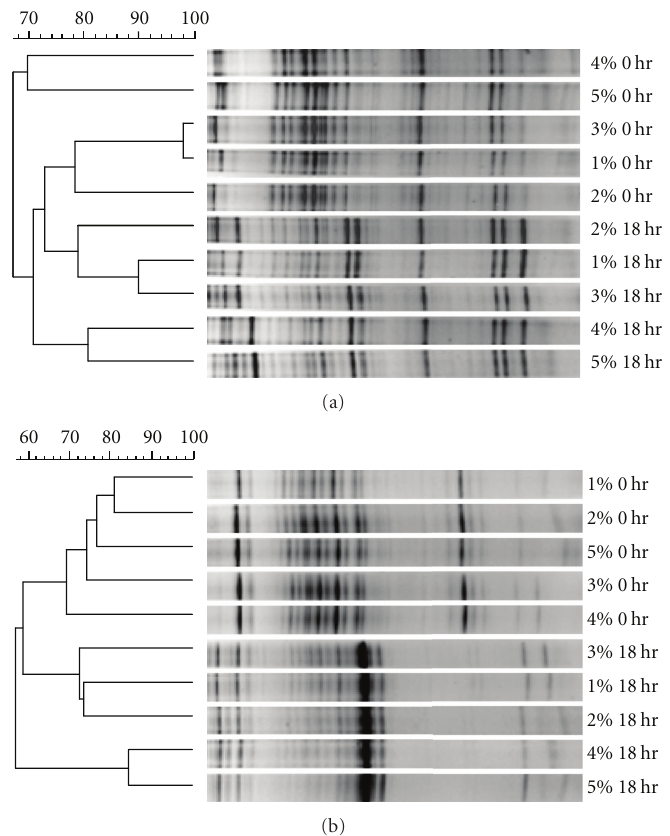
Figure 2: The comparison of DGGE profiles from di ff erent inoculum amounts. The clustering analysis based on Dice coe ffi cient and DGGE profile obtained at zero time and after 18 hours. The percentage indicated the inoculum amount of fecal materials. (a) The profiles obtained from individual B. (b) The cluster analysis were conducted with profiles of individual C. Table 3: Quantification of total bacteria, Bacteroidetes and Firmicutes in di ff erent inoculum amounts of human feces from 3 individuals. All of the copy numbers were obtained from triplicate real-time PCR analyses. The e ffi ciencies were 91.2% for total bacteria, 72.6% for Bacteroidetes , and 75.9% for Firmicutes .